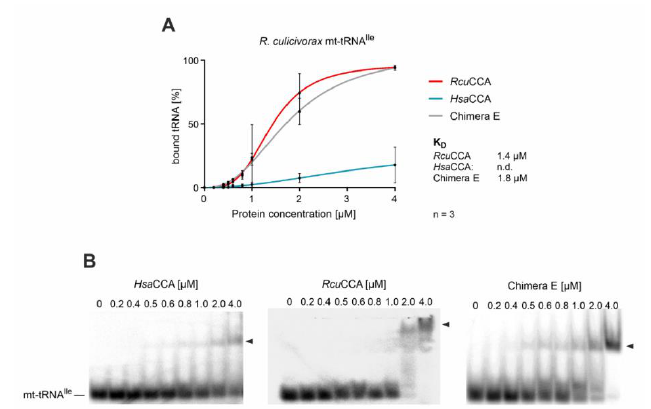
Figure 4. Binding of wt and chimeric CCA-adding enzymes to an armless tRNA. Quantitative analysis of enzyme binding to the armless mt-tRNA Ile determined by electrophoretic mobility shifts. ( A ) While the tRNA interaction of Hsa CCA over the whole concentration range (0 – 4 µM) is too weak to calculate dissociation constants, Rcu CCA as well as chimera E exhibit a strong affinity to this substrate, resulting in dissociation constants of 1.4 and 1.8 µ M, respectively. Data are means ± SD; n = 3. ( B ) Images of representative gel shift assays on Hsa CCA, Rcu CCA, and chimera E with mt-tRNA Ile as